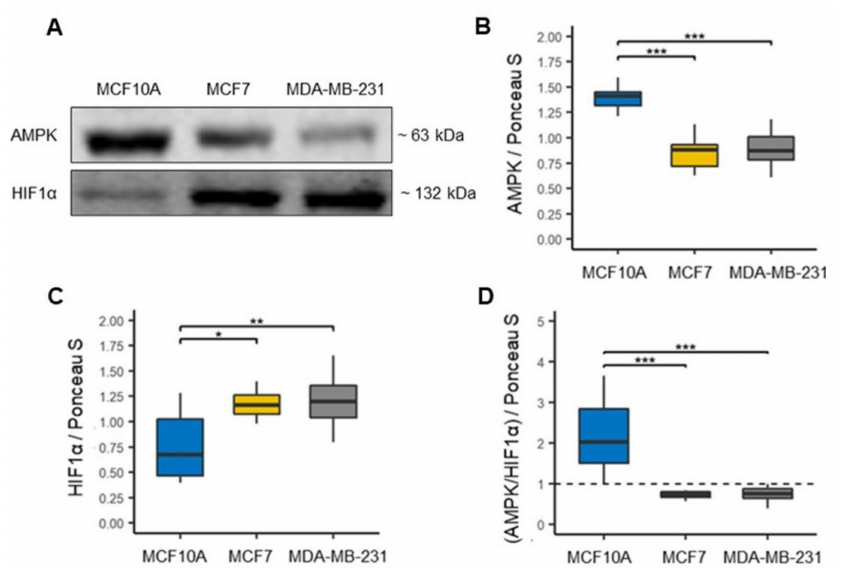
Figure 5. Metabolic reprogramming in breast cancer cell lines. ( A ) Representative blots. ( B ) Expres- sion of oxidative metabolism marker, adenine mono-phosphate-activated protein kinase (AMPK), n = 12. ( C ) Expression of glycolytic metabolism marker, hypoxia-inducible factor 1 α (HIF1 α ), n = 12. ( D ) AMPK/HIF1 α ratio in MCF10A, MCF7 and MDA-MB-231 cell lines, a ratio less than one (black line) reflects a preferential glycolytic metabolism. Densitometry values were normalized by Ponceau S red staining. The data are presented as mean ± SD. * p < 0.05, ** p < 0.01, *** p <